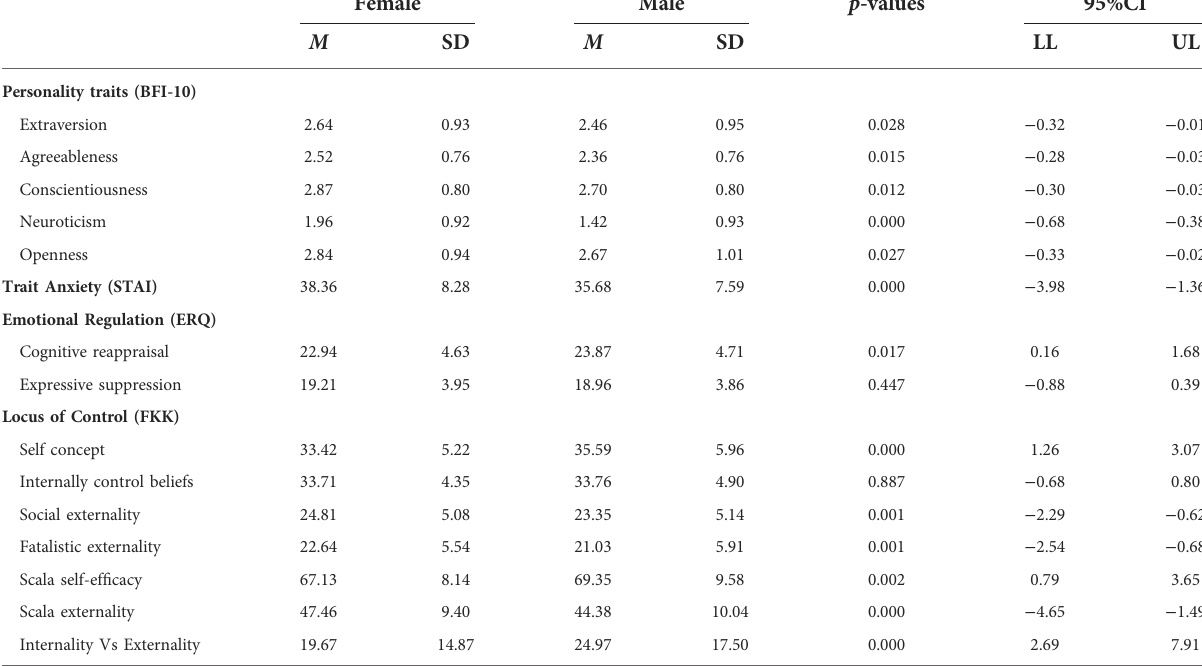
TABLE 2 Descriptive characteristics: psychological traits and characteristics differences between female and male.